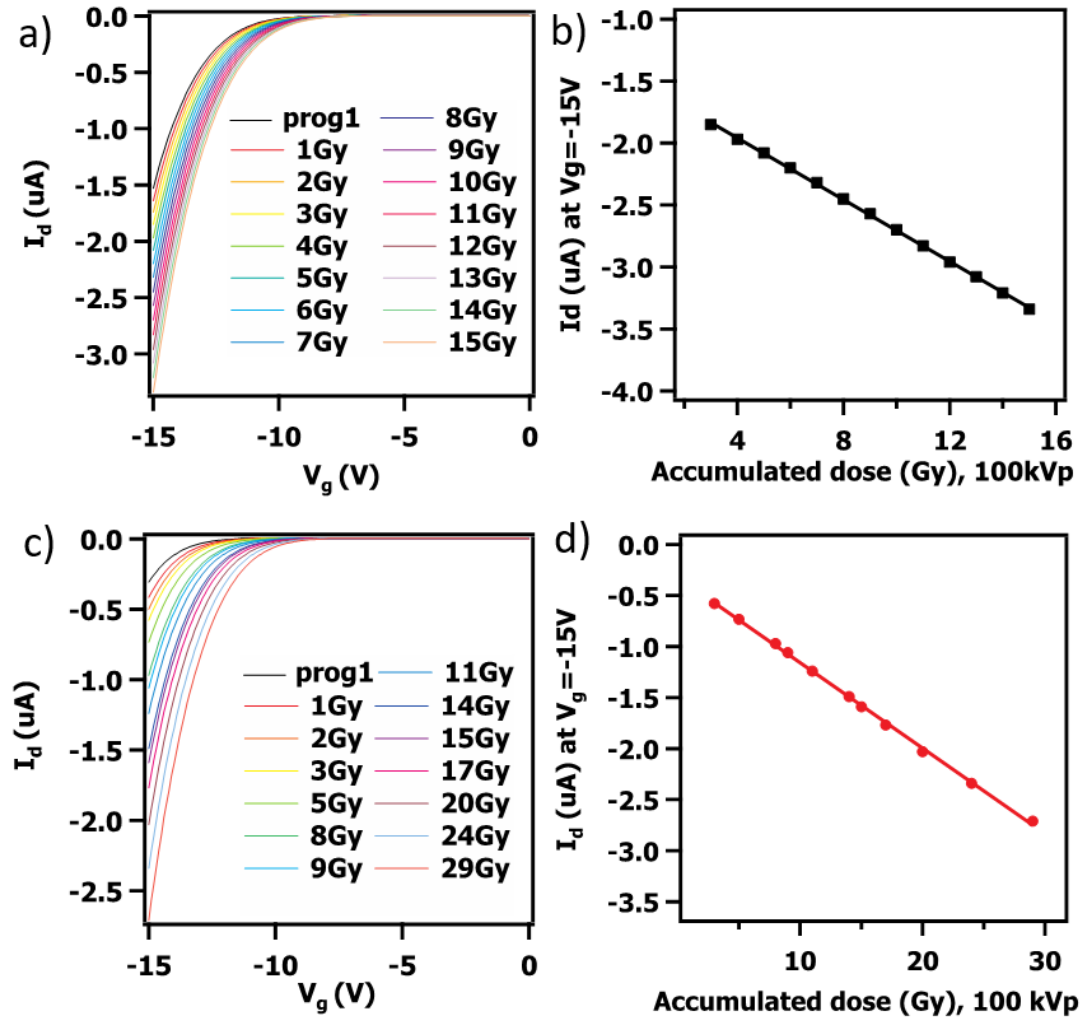
Figure 5. Transfer characteristics of pentacene OTFTs with PS electret after first programming and consequent accumulated irradiation with ( a ) 1 Gy steps and ( c ) variable dose steps. ( b , d ) The corresponding drain current value at V g = − 15 V as a function of accumulated dose. Irradiations were performed with a 100 kVp photon beam. The 1 and 2 Gy points have been excluded in the fit, as the sensitivity was more variable at these low doses. ‘Prog1’ refers to the I–V curve following the programming at − 80 V for 3 s.